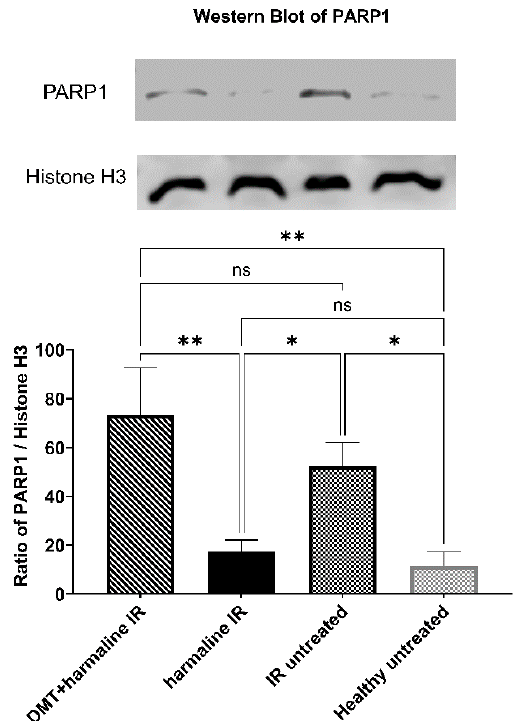
Figure 5. Western blot results: Expression levels of Poly [ADP-ribose] polymerase 1 (PARP1) in the different groups. All results are plotted as mean percentages + SEM. ns = non-significant; * = p < 0.05; ** = p < 0.01.